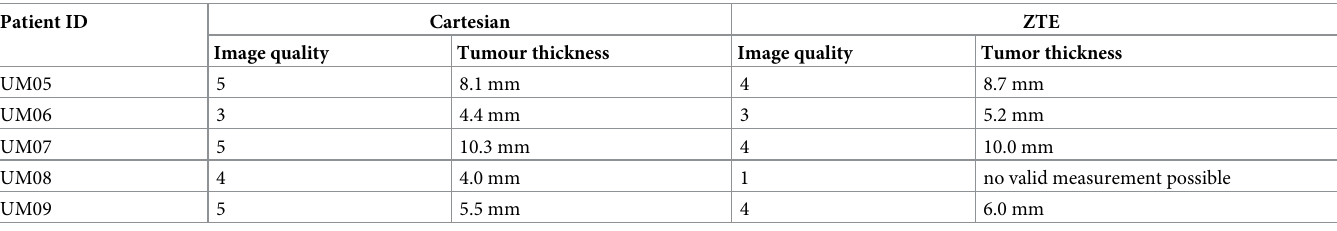
Table 3. Comparison of the image quality and the measured tumor thickness on Cartesian and ZTE images.